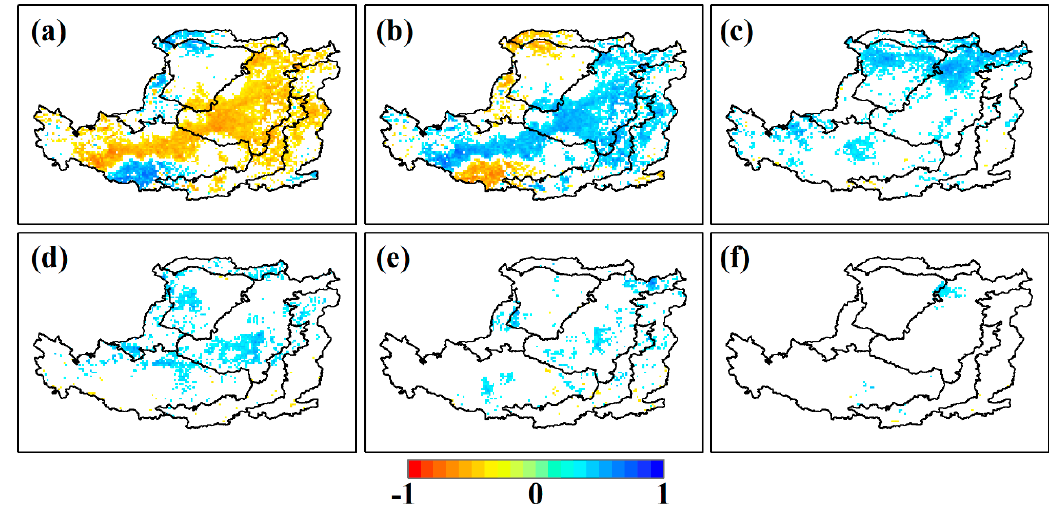
Figure 5. Correlations between different precipitation intensity changes and land cover change during the period 1982–2015. ( a ) No precipitation; ( b ) light precipitation; ( c ) moderate precipitation; ( d ) heavy precipitation; ( e ) very heavy precipitation; ( f ) severe precipitation. Please note that all sub-figures only show significant correlations at the 0.05 statistical level.